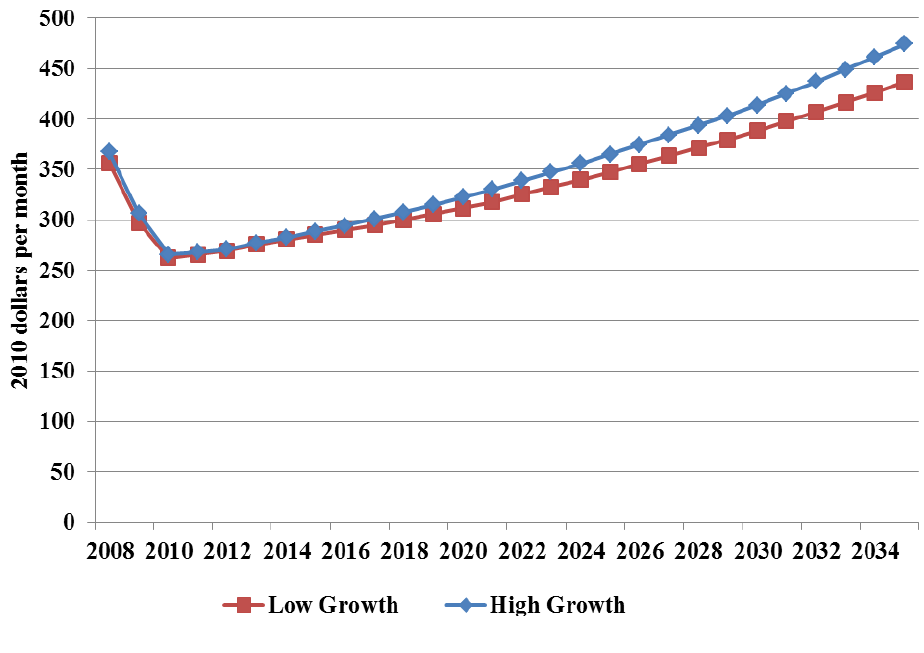
Figure 10. Real monthly household energy expenditures.